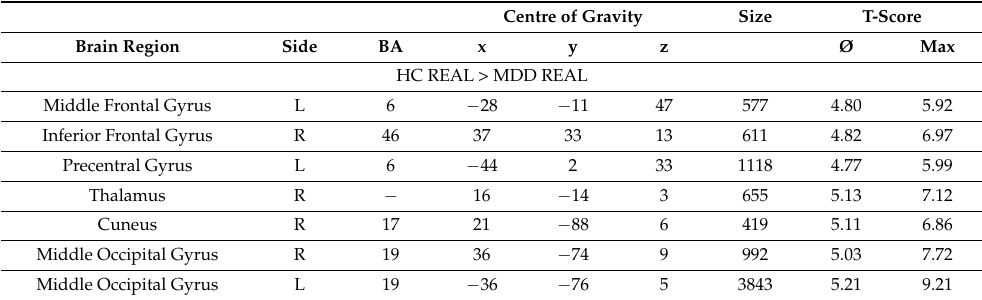
Figure 2. Hemodynamic responses of the emotion-associated task before the NF training (negative emotional pictures > neutral pictures; q (FDR) < 0.001, T-score: − 8 to 8, fixed-effects-analysis); in blue, increased responses of the HC REAL group, compared to MDD REAL, e.g., thalamus, primary visual cortex, and visual association cortex; in orange, increased activations of MDD REAL compared to HC REAL, e.g., insula, medial prefrontal cortex, superior temporal gyrus (x = 0; y = 15; z = 3). A = anterior, P = posterior, R = right. Table 5. Hemodynamic responses during the emotion-associated task of the functional localizer on day one (negative emotion-associated pictures minus neutral pictures; clusters of >30 voxels, q (FDR)< 0.001, T-score: 8 to −